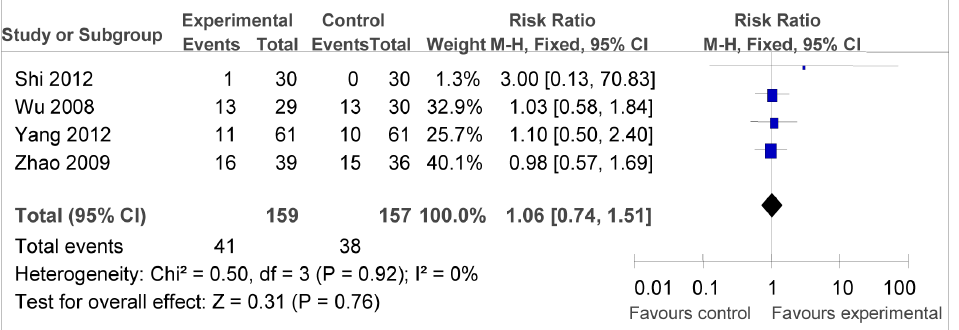
Figure 5. Forest plot of the comparison of overall response rate (ORR). P values are from P for the effect modification evaluation of heterogeneity within or across the groups of regimens. CI, confidence interval; RR, risk ratio; DC/CIK, DC-CIK immunotherapy; Chemo, chemotherapy; Con, control group; Exp, experimental group. A fixed-effect meta-analysis model (Mantel-Haenszel method) was used.